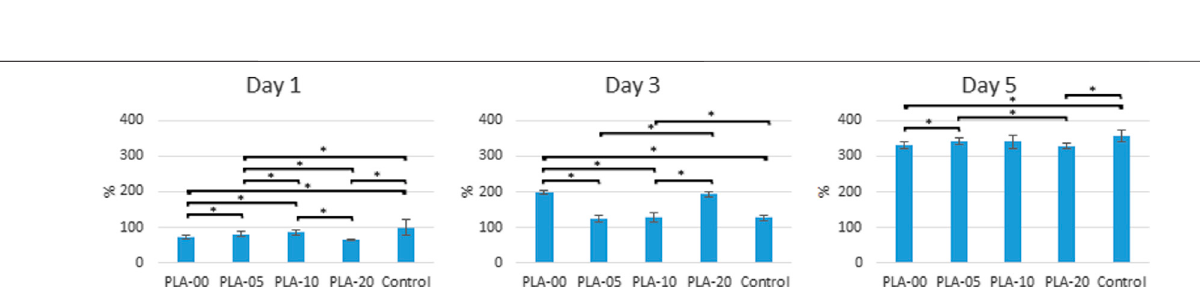
FIGURE 4 | Cell proliferation assay. All PLA/ β -TCP ratios were nontoxic, leading to cell proliferation during 5 days (* p < 0.05).